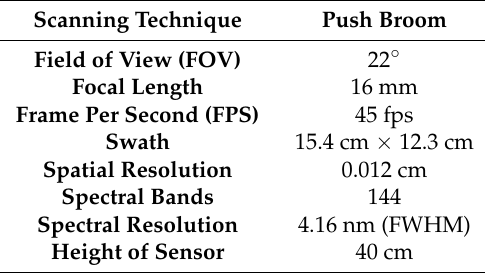
Figure 4. Laboratory setup of hyperspectral imaging system (HSI). Table 1. Specifications of hyperspectral sensor.